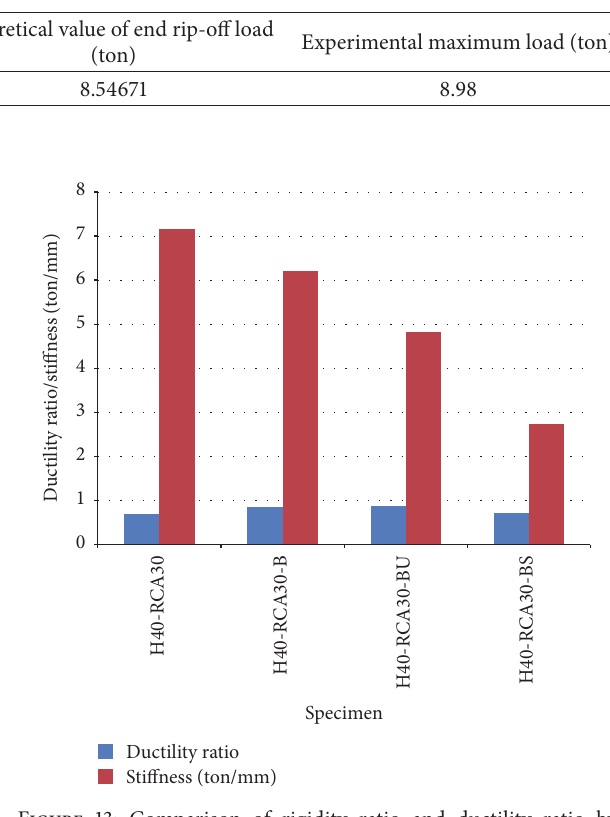
Table 7: Comparative analysis of H40-RCA30-B.